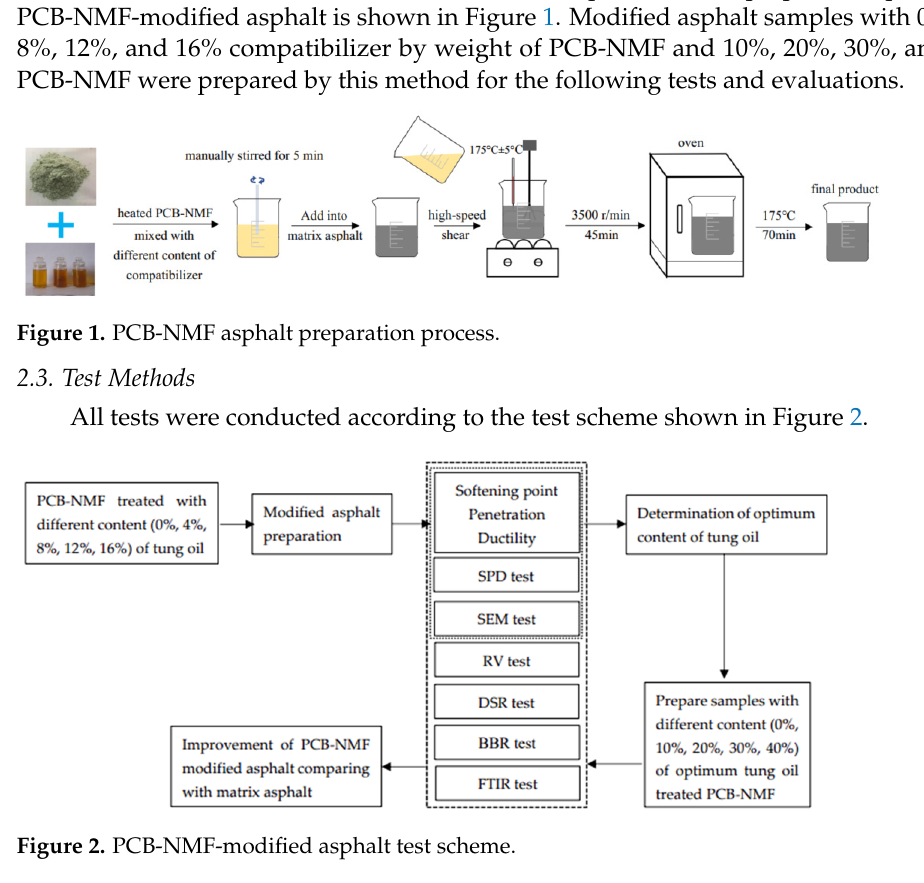
Table 2. The physical and chemical properties of compatibilizer.